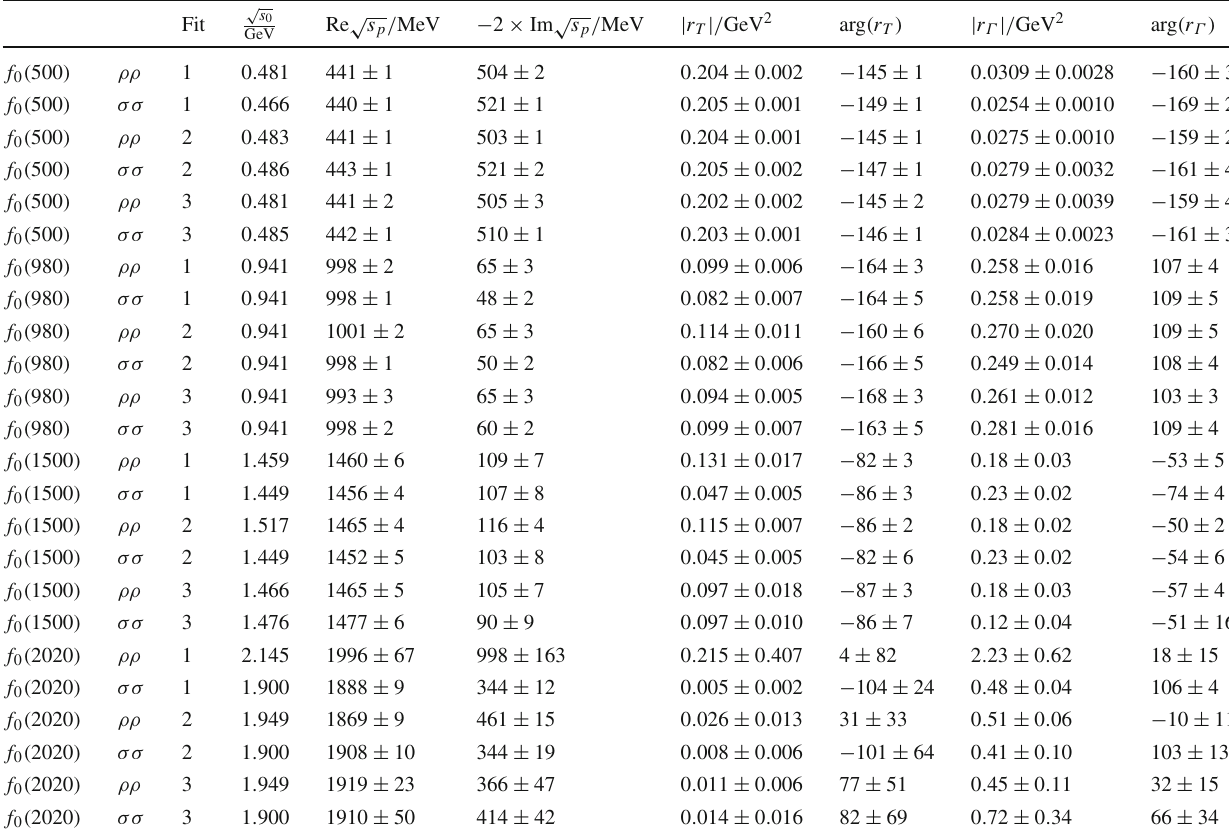
Table 2 Padé poles for f 0 ( 500 ) , f 0 ( 980 ) , and f 0 ( 1500 ) for N = 5, as well as f 0 ( 2020 ) for N = 6. The error is the uncorrelated sum of statistical and systematic